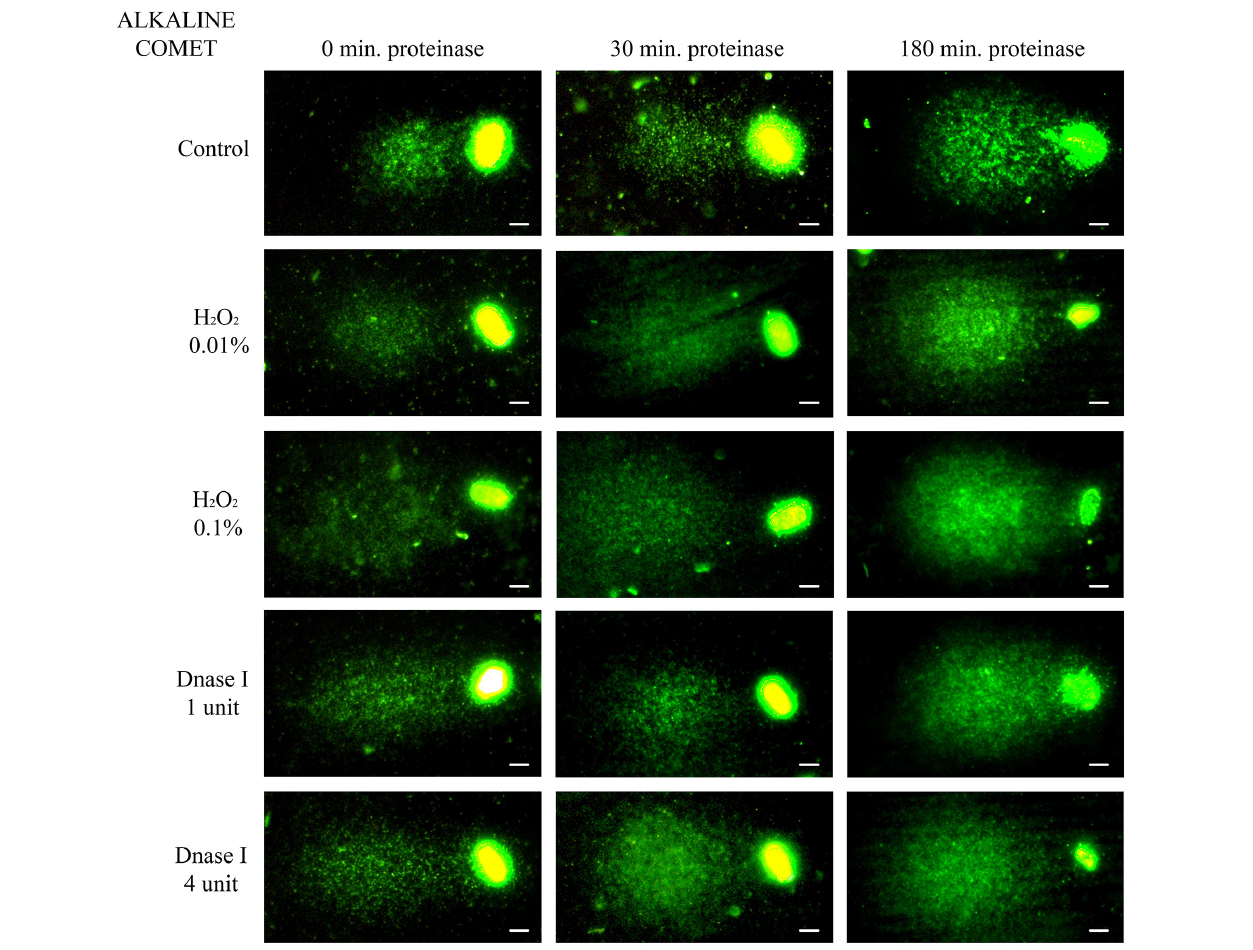
FIGURE 2 | Representative images of the alkaline Comet after incubation with the additional lysis solution containing proteinase K (columns) for different times and after treating samples with H 2 O 2 and DNAse I (rows). Scale bar: 5 µ